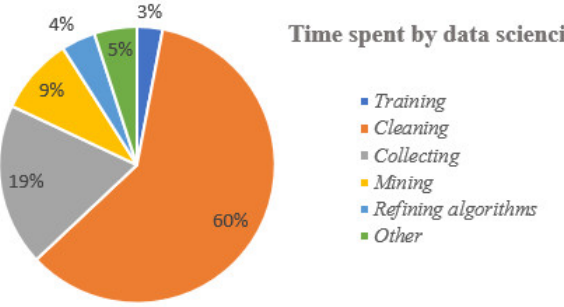
Figure 5. Percentage of time consumed by data scientists. Adapted from [19].